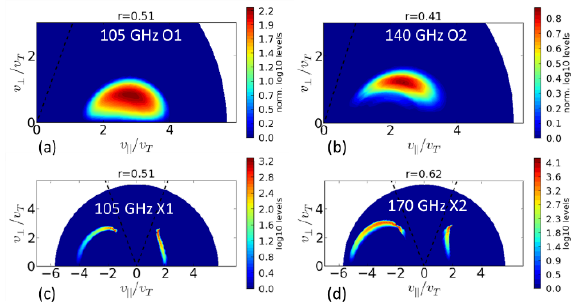
Fig. 9. The quasi-linear diffusion coefficient ( D QL ) in velocity space obtained from CQL3D simulation for (a) the up-shift 105 GHz fundamental harmonic O-wave, (b) the up-shift 140 GHz second harmonic O-wave, (c) the down-shift 105 GHz fundamental harmonic X-wave, and (d) the down-shift 170 GHz second harmonic X-wave.